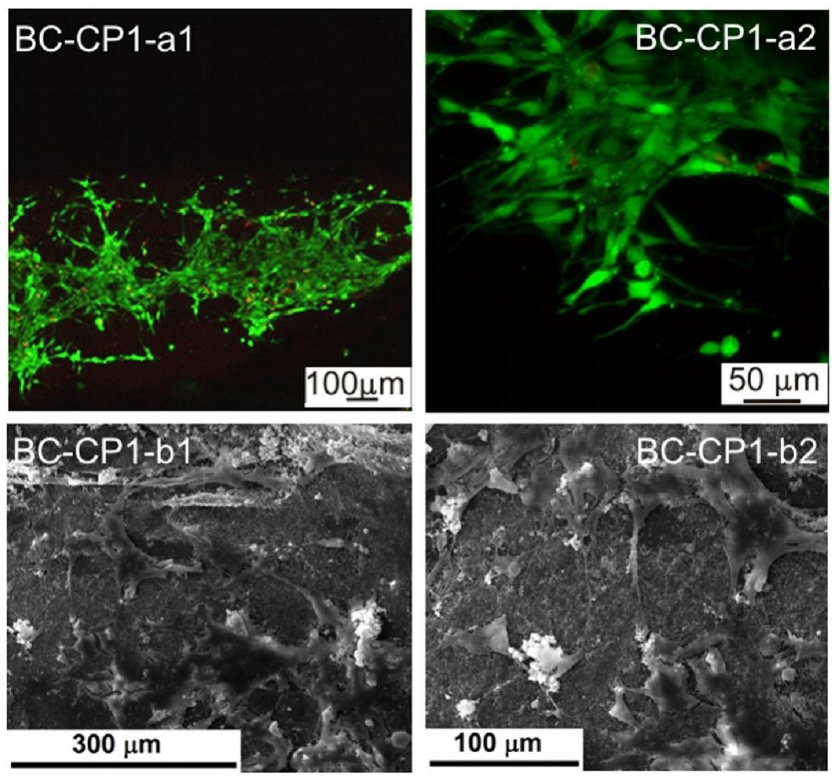
Figure 10. Fluorescence microscopy images ( a1 , a2 ) and SEM images ( b1 , b2 ) of the adherent cells on a BC-CP1 sample.